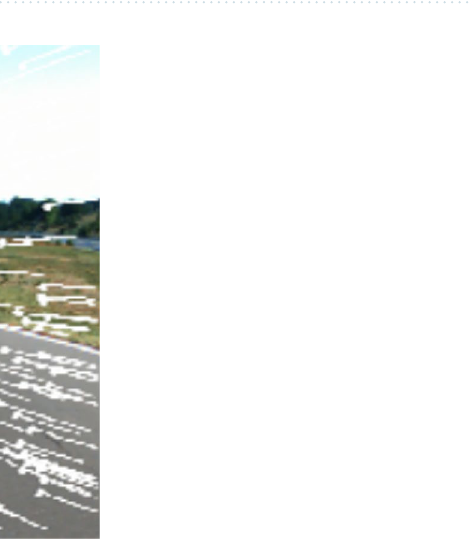
Figure 2. Optical flow generated by surrounding